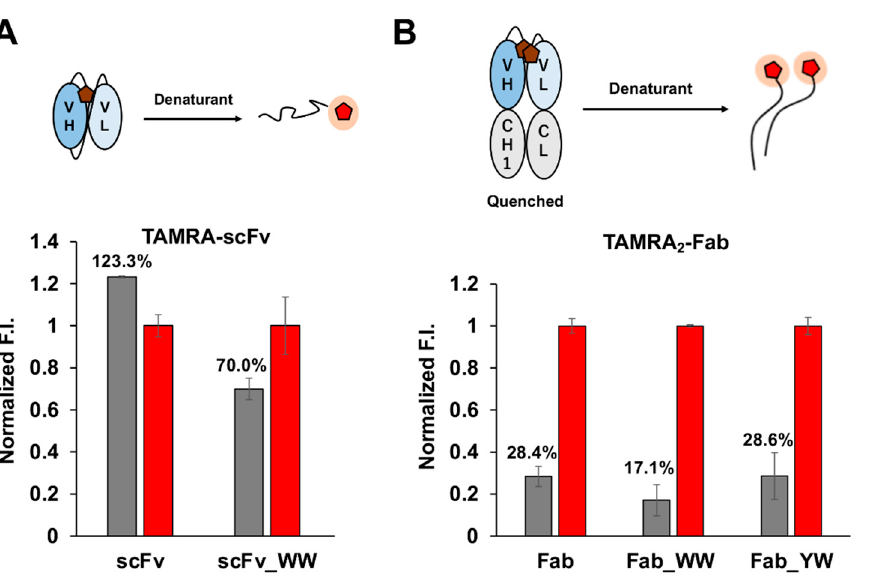
Figure 3. Quenching efficiency of 5-TAMRA C6 labeled antibody fragments, where the fluorescence intensity of denatured state was set to 1. ( A ) Quenching efficiency of single labeled scFv fragment with and without WW mutation, and ( B ) that of double-labeled Fab Q-bodies. Gray and red bars represent the fluorescence intensity of quenched and denatured Q-bodies, respectively. The fluorescence intensities were normalized by the mean intensity of each Q-body (1 nM) in the denaturant. Error bars indicate ±1 standard deviation (SD) (n = 3).